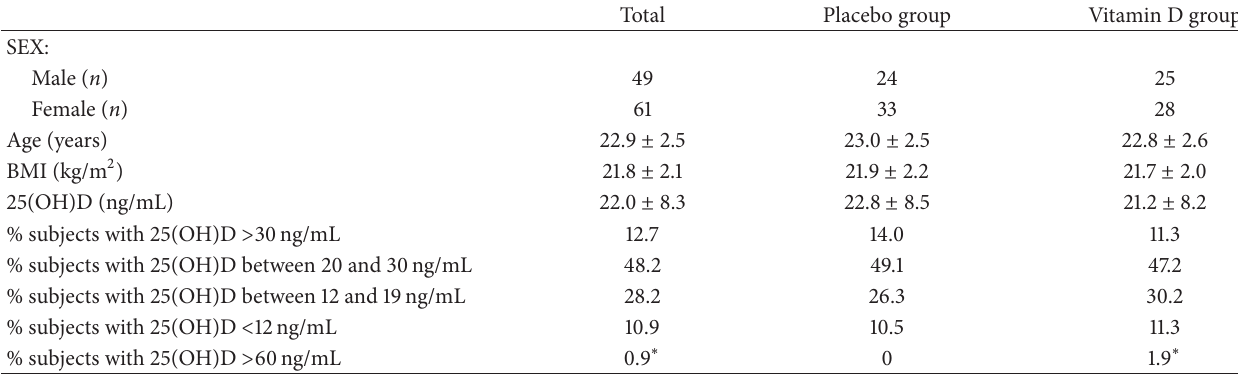
Table 1: Baseline demographic data of the healthy young Belgian volunteers who agreed to participate in the study. Continuous variables are expressed as mean ± SD.